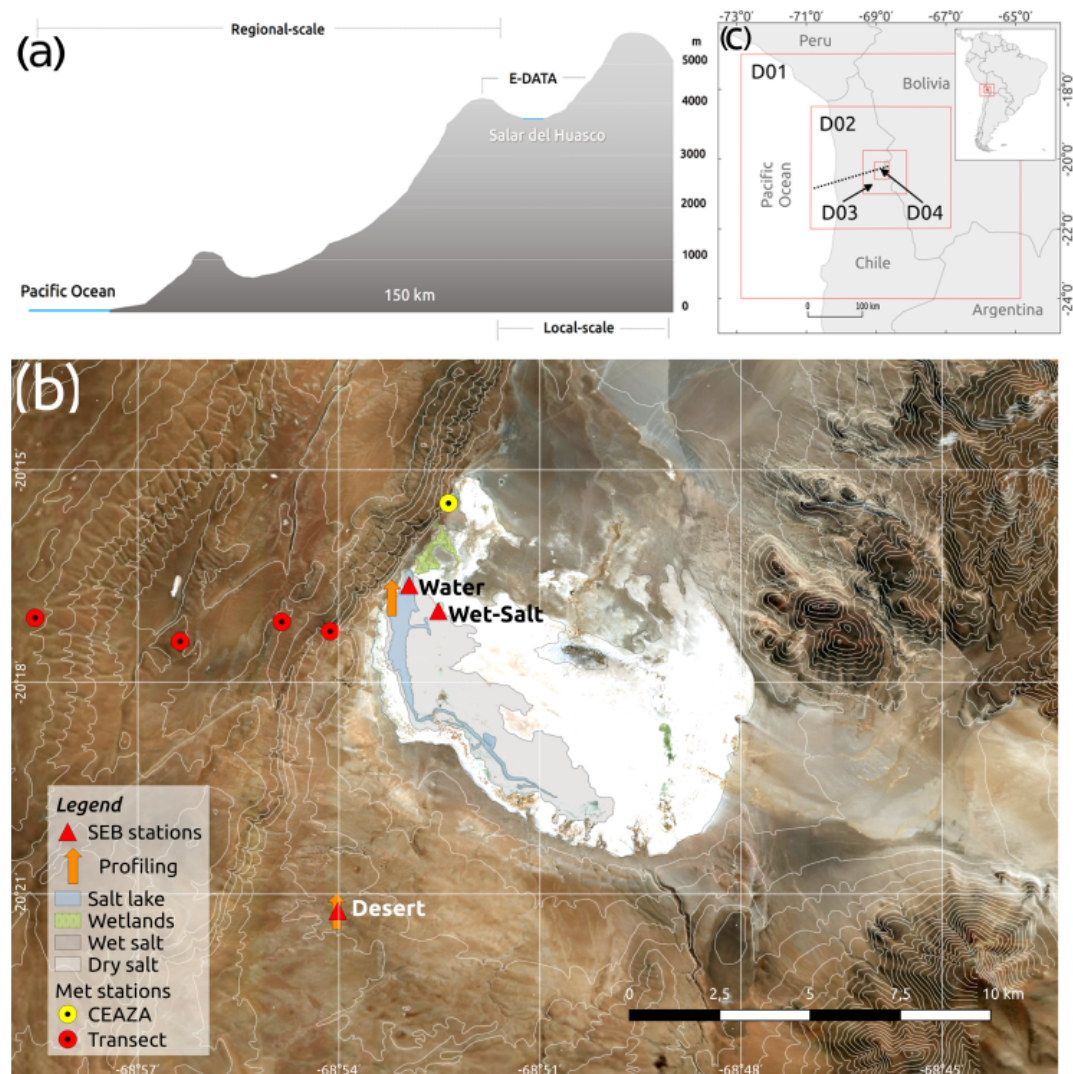
Figure 2. Study site. (a) Vertical cross section of western slope of the Andes, showing the spatial scales involved in the field experiment and modelling. (b) Spatial distribution of surface and vertical observations at SDH site during the E-DATA field experiment used in this study (contains modified Copernicus Sentinel data processed by Sentinel Hub). (c) WRF outer domains D01 (27km) and D02 (9km) and inner domains D03 (3km) and D04 (1km). The SDH saline lake is located at the centre of the D04 and dotted line indicates the vertical cross section shown in Sect.